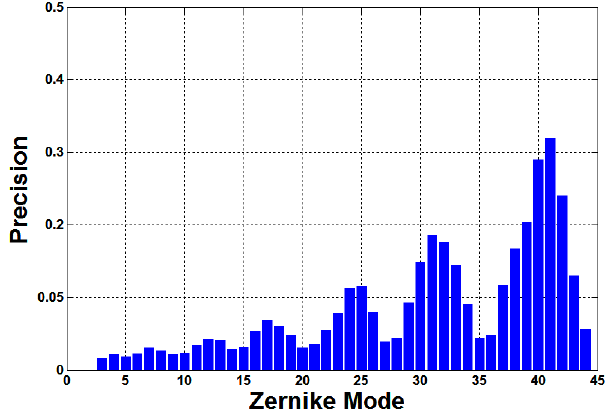
Fig. 5. The correction capability of wavefront errors of the 169-element PZT